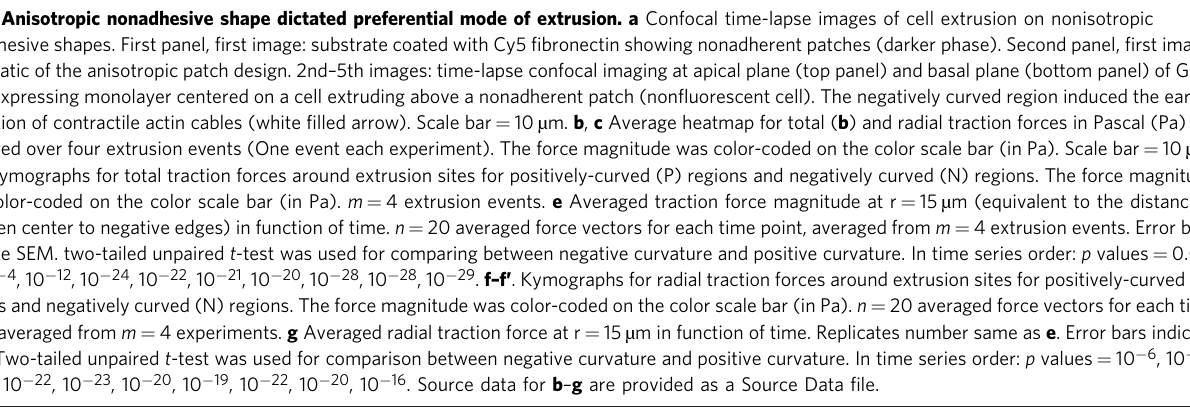
Fig. 8 Anisotropic nonadhesive shape dictated preferential mode of extrusion. a Confocal time-lapse images of cell extrusion on nonisotropic nonadhesive shapes. First panel, fi rst image: substrate coated with Cy5 fi bronectin showing nonadherent patches (darker phase). Second panel, fi rst image: schematic of the anisotropic patch design. 2nd – 5th images: time-lapse confocal imaging at apical plane (top panel) and basal plane (bottom panel) of GFP- actin expressing monolayer centered on a cell extruding above a nonadherent patch (non fl uorescent cell). The negatively curved region induced the earlier formation of contractile actin cables (white fi lled arrow). Scale bar = 10 µ m. b , c Average heatmap for total ( b ) and radial traction forces in Pascal (Pa) ( c